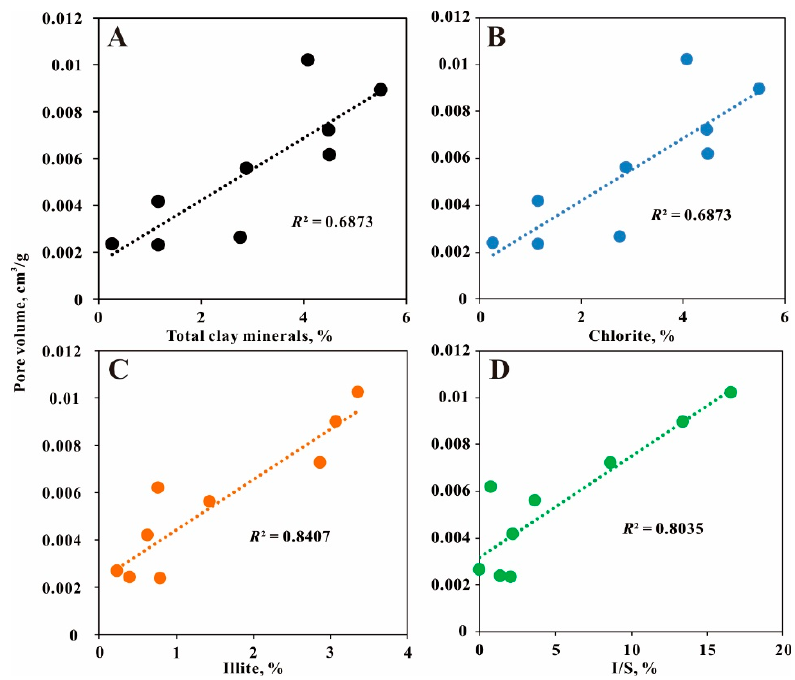
Figure 16. Positive correlations between pore volume derived from N 2 GA experiments and contents of total clay minerals ( A ), chlorite ( B ), illite ( C ), I/S ( D ).